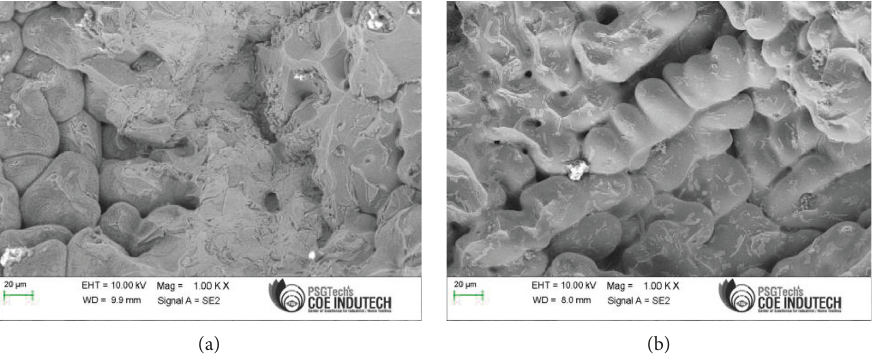
Figure 17: SEM analysis of fractured creep samples: (a) AA7075 and (b) AA7075/1wt%TaC/8wt% Si